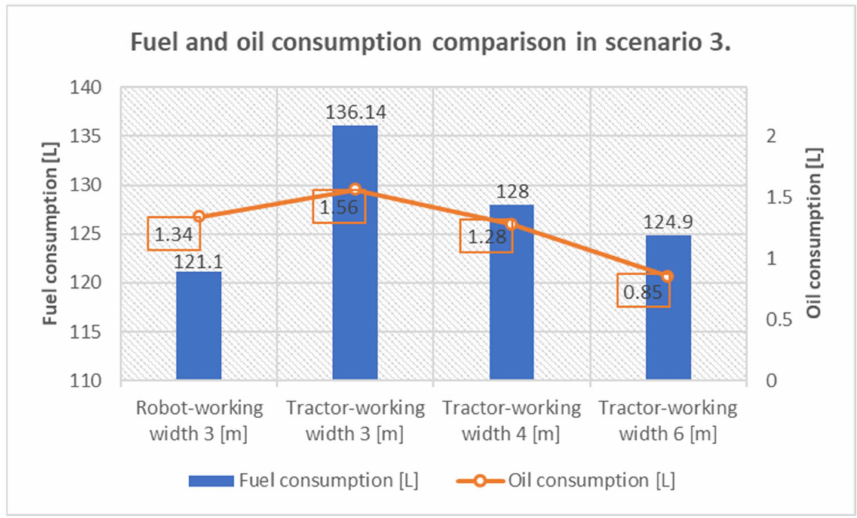
Figure 19. The comparison of fuel and oil consumption between robot and tractor in scenario 3. Figure 20 shows that the robot has up to 44% less operational costs per hour than the tractor. The comparison of total cost shows that the robot has up to 41% less total cost per hour than the tractor. The comparison of the total cost of the operation shows that the robot has up to 28% less cost than the tractor with a 3–4 m working width. The tractor with 6 m working width has 11% less cost than the robot. Moreover, the comparison of CO 2 emission shows that the robot has up to 11% less CO 2 emission than the